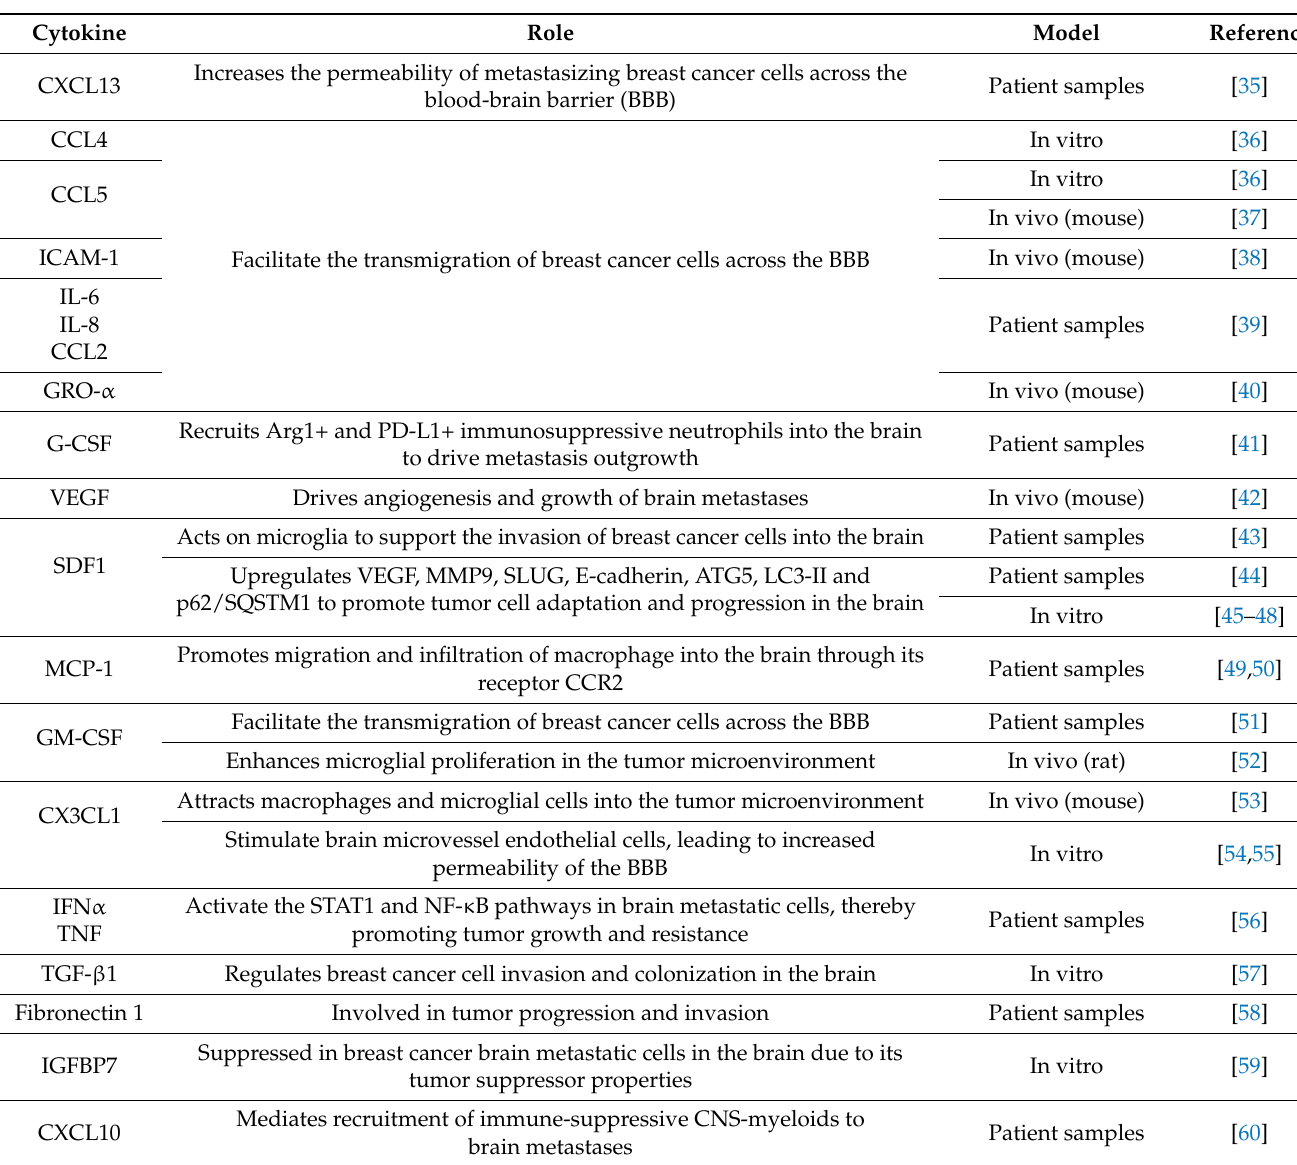
Table 2. Cytokines reported to have a role in breast cancer brain